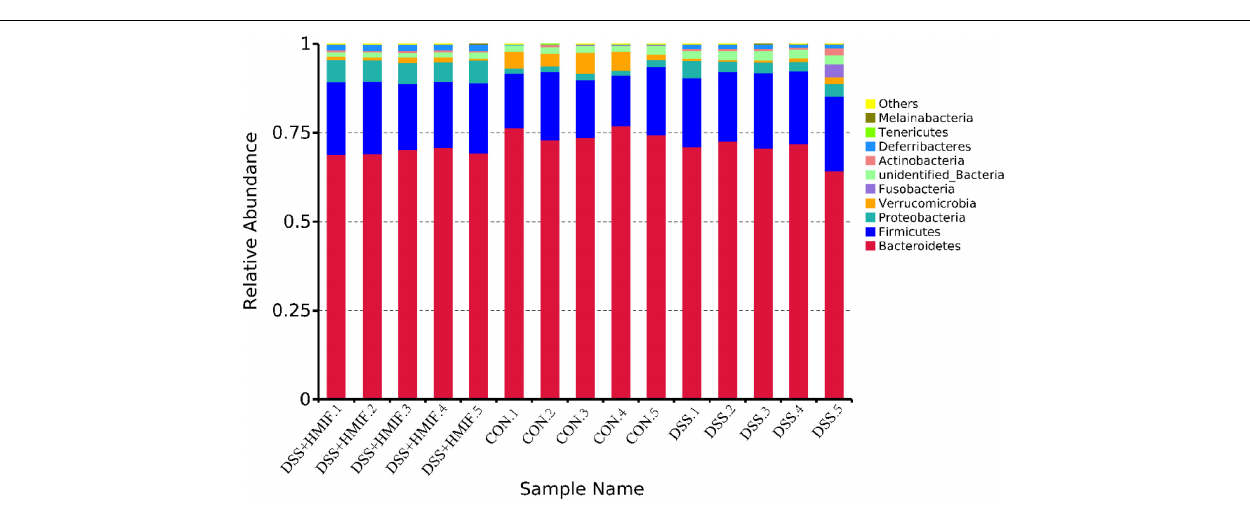
FIGURE 6 | Relative abundances of the dominant bacteria at phylum level in the colon of C57BL/6J mice among the three groups. CON, control; DSS, dextran sulfate sodium (DSS) treatment; HMIF, DSS treatment + 200 mg/kg fruiting bodies of Morchella importuna